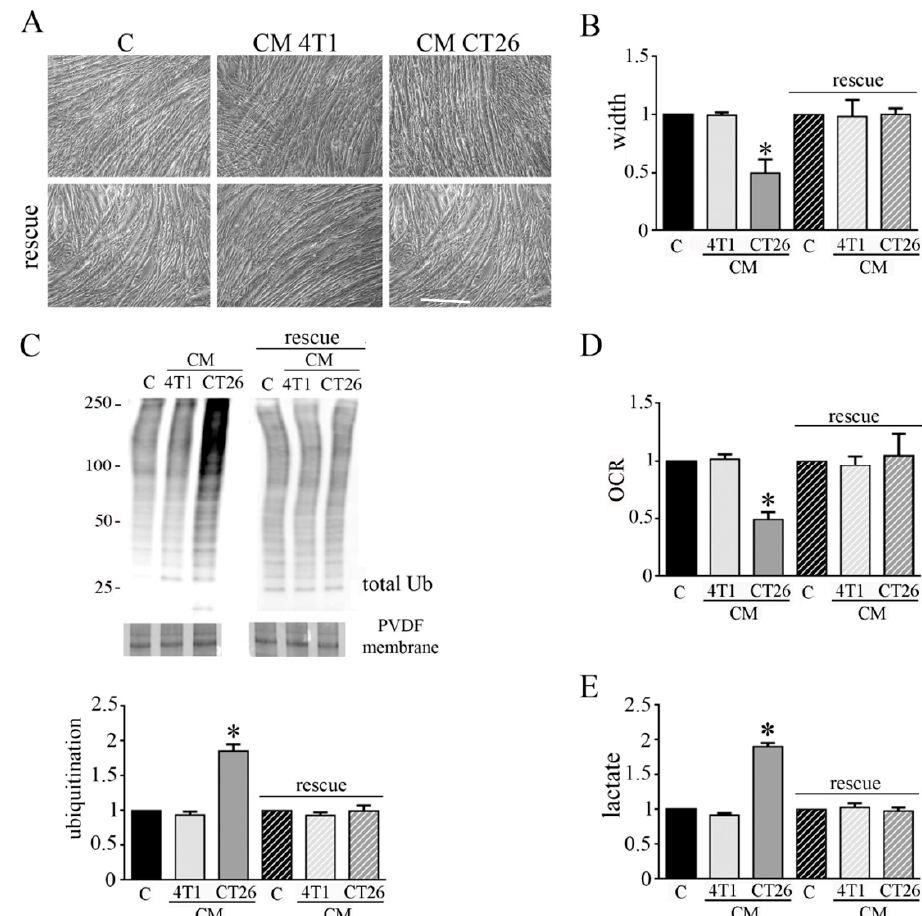
Figure 6. CM CT26 removal restores normal phenotype and metabolism in myotubes. Four-day-differentiated myotubes were treated with 24 h with CM 4T1 or CM CT26. CMs were then removed, and differentiating medium was added to myotubes for additional 48 h. Control myotubes, indicated as C, were treated with differentiating medium throughout the experiment. ( A ) Microscopic images of myotubes before CM removal (images above) and after the treatment with differentiating medium (images below). Scale bar: 100 µm. ( B ) Measure of myotube width. ( C ) Immunoblot of ubiquitinated proteins in myotubes. Normalized ubiquitination level was obtained by using Coomassie-stained PVDF membrane. ( D ) Oxygen consumption rate (OCR) analysis. ( E ) Lactate assay. All the values in the bar graphs are reported as fold increase, considering control myotubes as 1; n = 4; * p < 0.05.